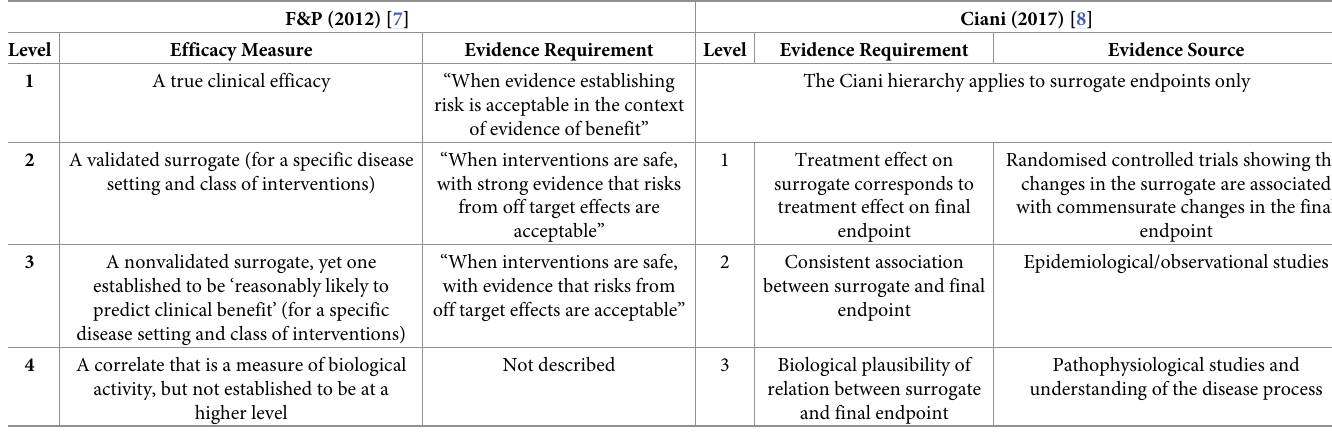
Table 2. Hierarchy of evidence for surrogate endpoint